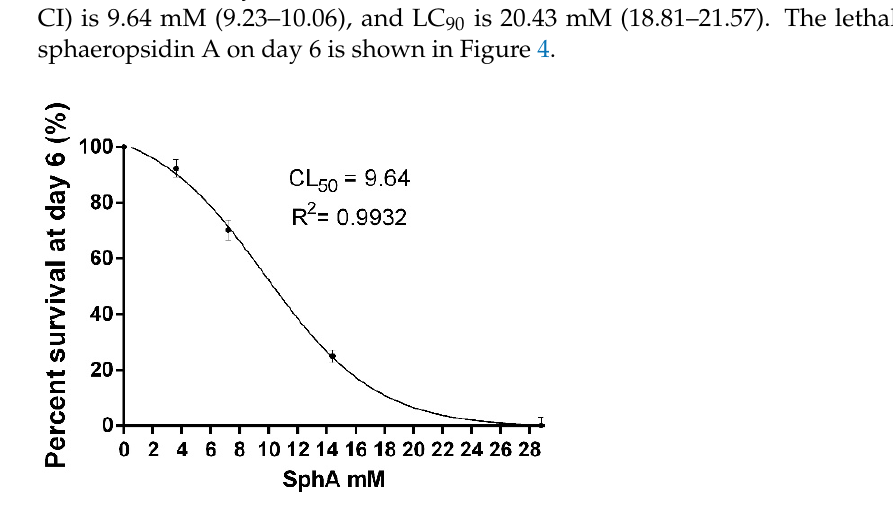
Figure 3. Sphaeropsidin A oral toxicity on A. pisum . Aphids’ survival rate was negatively affected by sphaeropsidin A oral administration. Asterisk indicates a statistical difference to log ‐ rank (Mantel–Cox) test ( p < 0.0001).